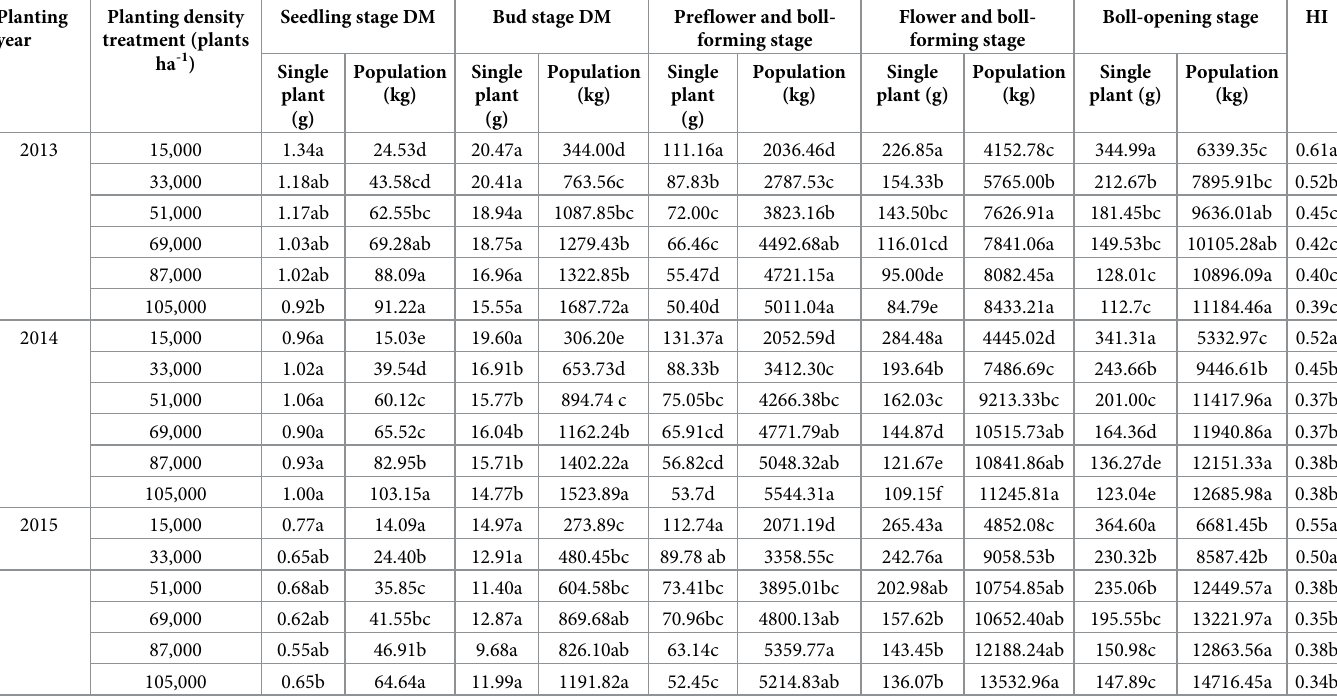
Table 3. Dry matter production (DM) and harvest index (HI) values of different stages of cotton at different planting densities from 2013 to 2015.